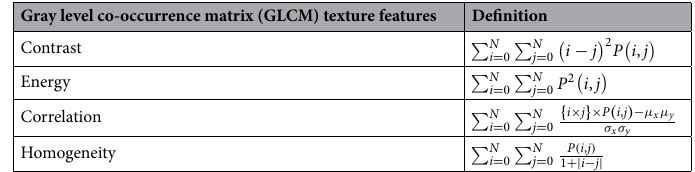
Table 5. Discrete probabilities P ( i , j ) of gray level co-occurrence matrix for distance d is (1,1), with N is the number of clusters used in an image of a lesion. µ x , µ y , σ x , and σ y are the mean and standard deviations of P x and P y . P x ( i ) is the i -th entry in the marginal-probability matrix obtained by summing the rows of P ( i, j ): P x ( i ) =